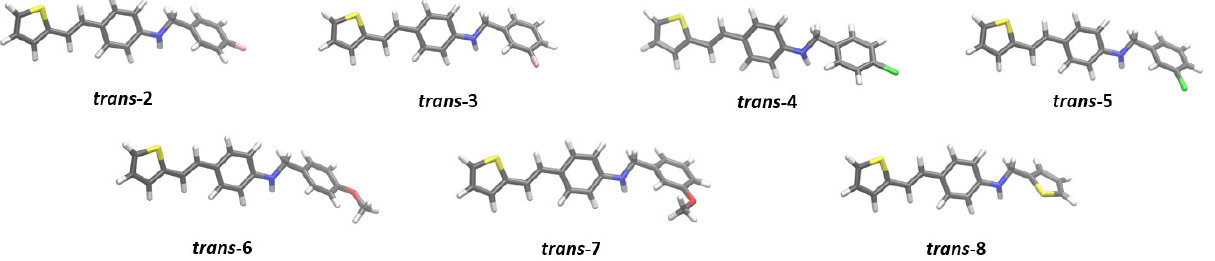
Figure 8. The most stable conformers of trans -isomers of styryl-thiophene benzylamines 2 – 8 , optimized at the M06-2X/6-31g(d) level of theory.